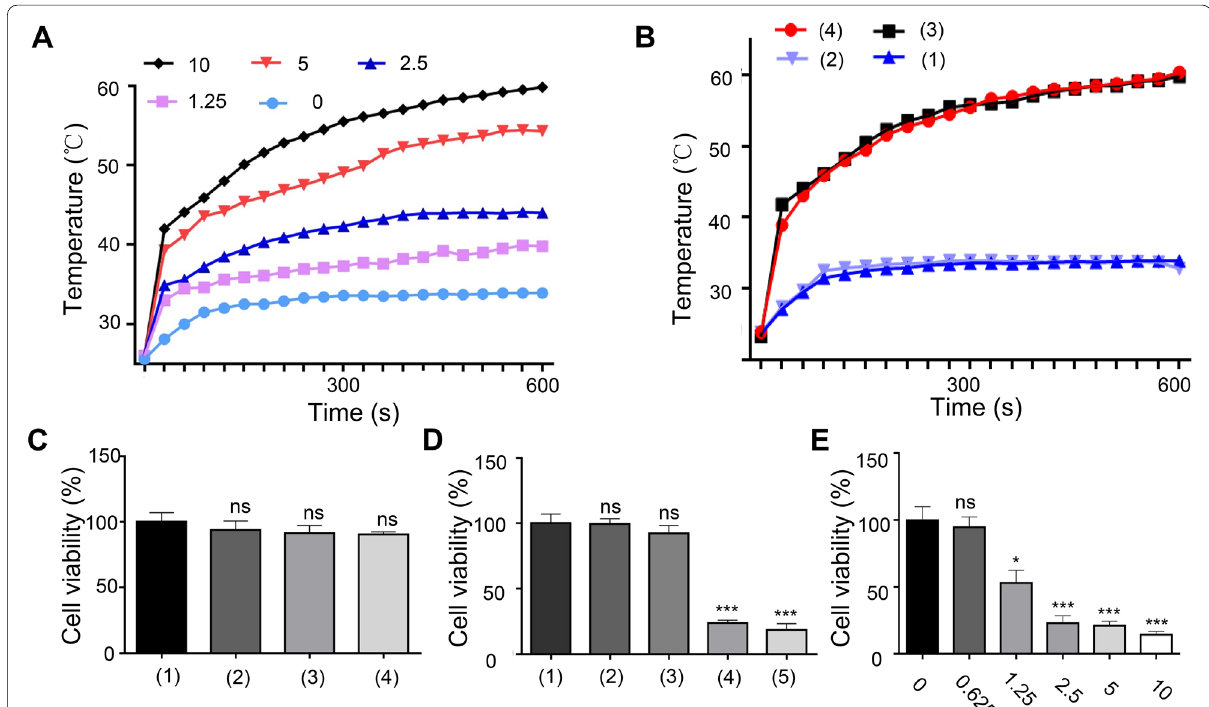
Fig. 3 Photothermal properties and cell cytotoxicity of PPCu-mediated PTT. A Temperature elevation levels of PPCu in different concentrations (mg/mL) under NIR laser irradiation. B Temperature changes of different nanocapsule formulations with NIR laser irradiation. (1), (2), (3), and (4) representing H 2 O@PLGA NIR, PFP@PLGA NIR, Cu 12 Sb 4 S 13 @PLGA NIR, and PPCu NIR, respectively. C Relative cell viability of HepG2 + + + + cells treated with DMEM or different nanocapsules. (1), (2), (3), and (4) represent DMEM, PFP@PLGA, Cu 12 Sb 4 S 13 @PLGA and PPCu-treated cells, respectively. D Relative cell viability of HepG2 cells treated with different nanocapsule formulations under NIR laser irradiation. (1), (2), (3), (4), and (5) represent DMEM, NIR, PFP@PLGA NIR, Cu 12 Sb 4 S 13 @PLGA NIR and PPCu NIR-treated cells, respectively. E Relative cell viability of HepG2 cells + + + treated with different concentrations of PPCu. The x axis represents the concentration in mg/mL. Data are presented as the mean SD of three ± independent experiments. *compared with the control, p < 0.05. ** compared with the control, p < 0.01. *** compared with the control, p <